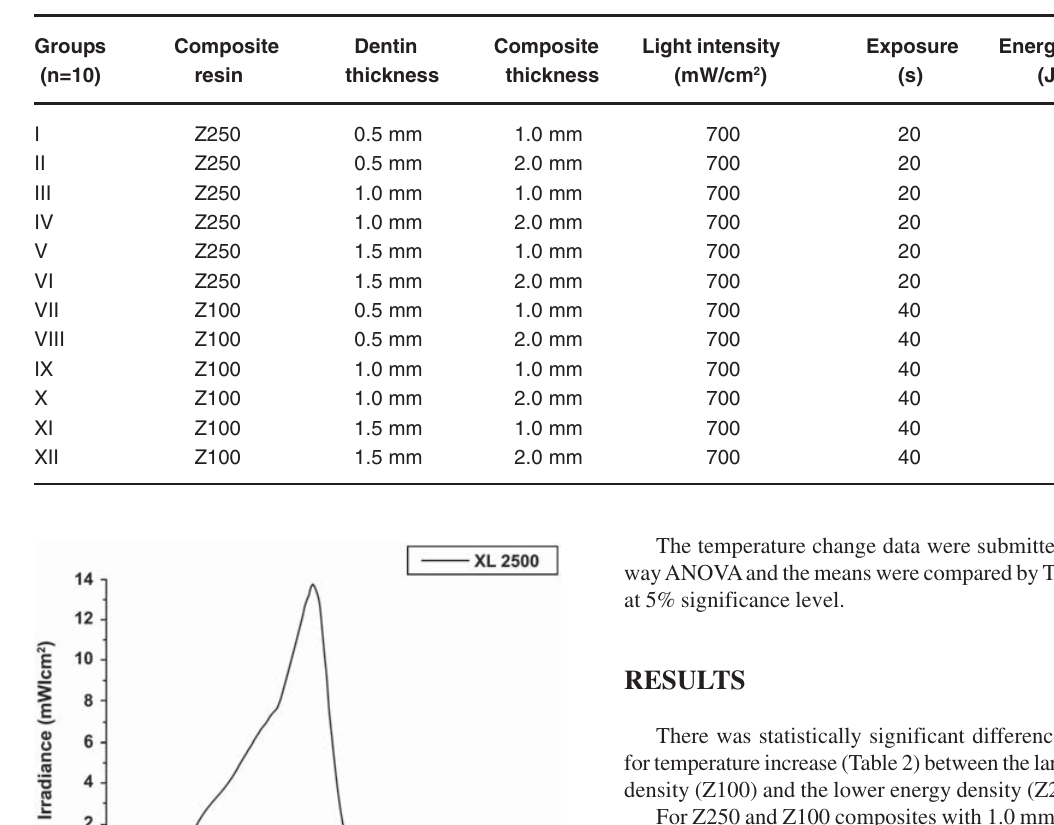
TABLE 1 - Characteristics of the experimental groups